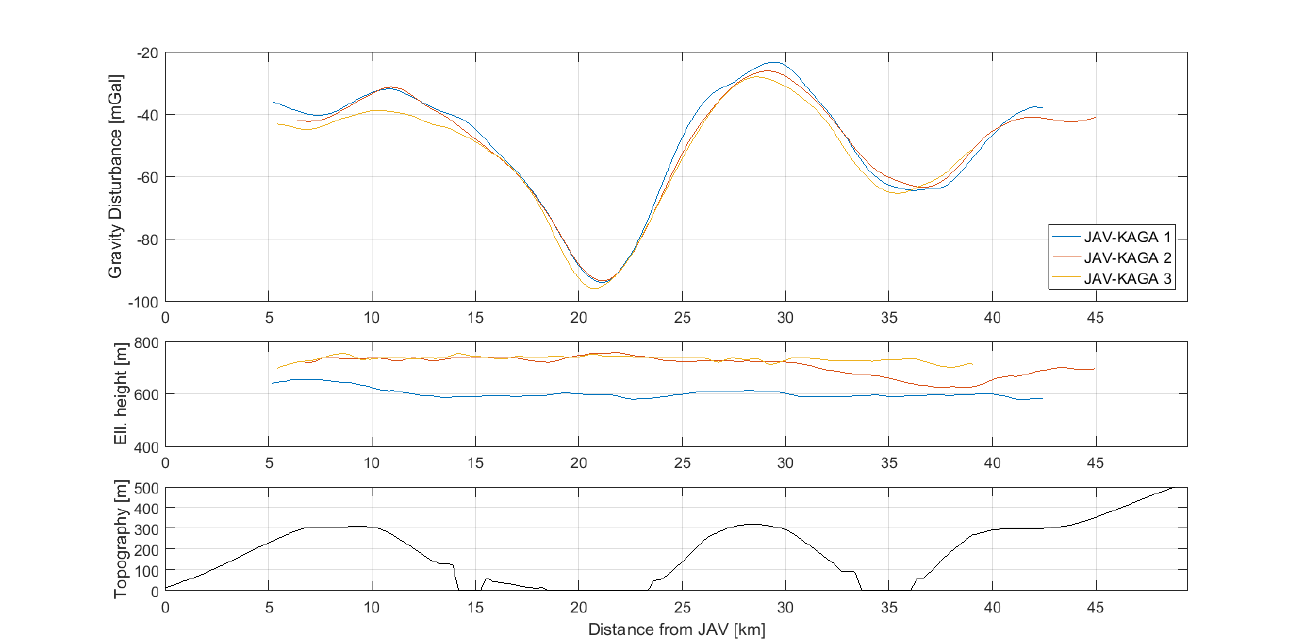
Figure 5. Profiles for the three repeated lines between JAV and KAGA. The gravity disturbance was modelled using a third-order Gauss–Markov model with uncertainty, σ = 57.84 mGal, and correlation, 1/ β = 5.647 km: ( top ) gravity disturbance estimates; ( middle ) ellipsoidal height; ( bottom ) topography from SRTM30 with respect to WGS84 ellipsoid.